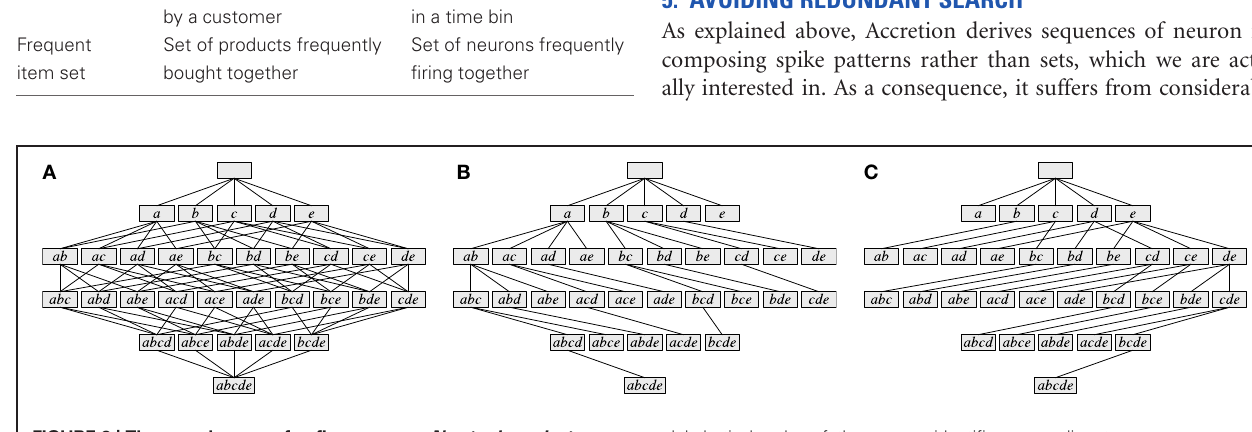
FIGURE 2 | The search space for five neurons N = { a , b , c , d , e } . (A ) Hasse diagram: a graph in which each possible set is a node and any two sets I , J ⊆ N with I ⊂ J are connected by an edge if and only if (cid:11) ∃ K : I ⊂ K ⊂ J . (B) A selection of edges from the Hasse diagram that reduces it to a search tree. Parents are assigned based on